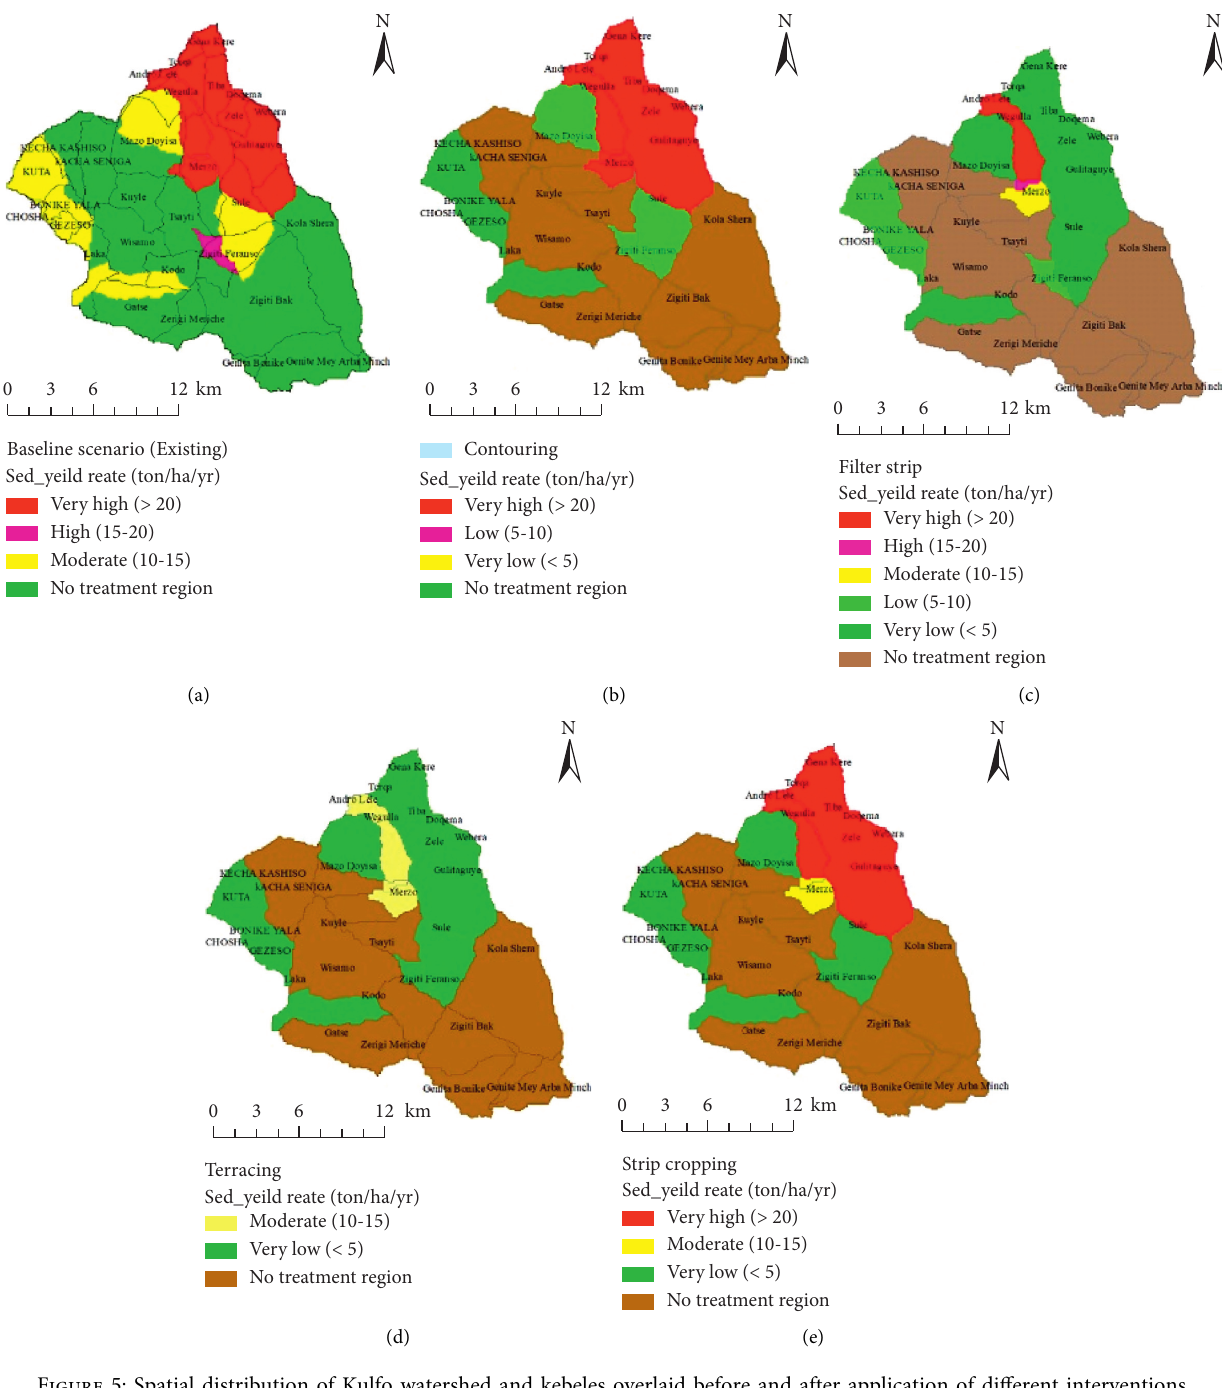
Figure 5: Spatial distribution of Kulfo watershed and kebeles overlaid before and after application of different